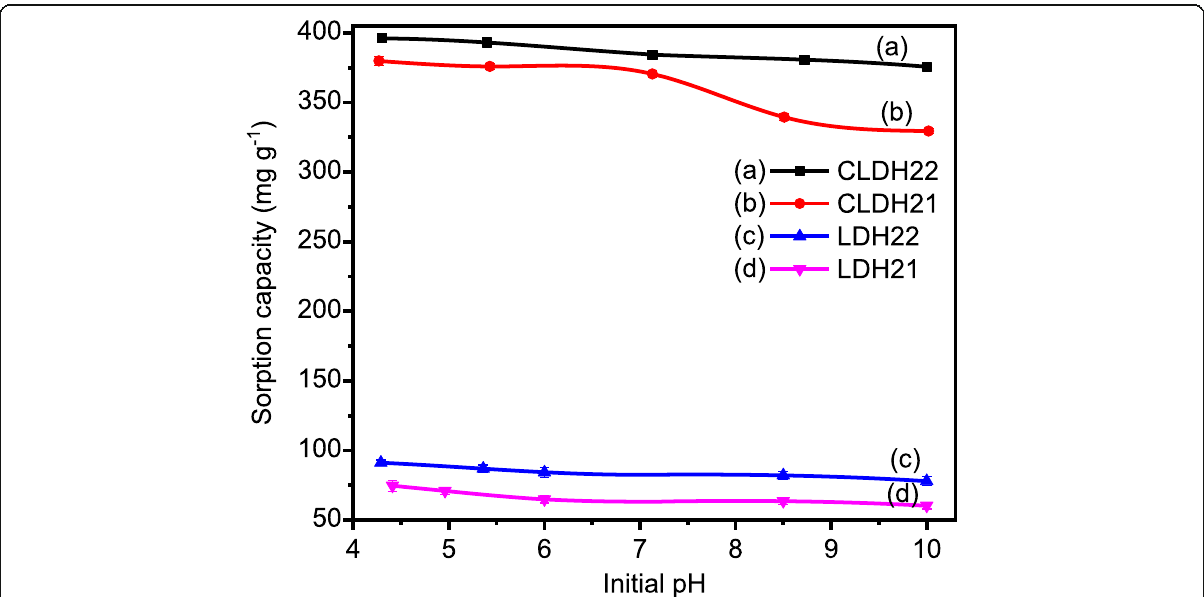
Fig. 4 Effect of initial pHs on adsorption capacity of IDB dye onto LDHs and CLDHs adsorbent, (C i = 200 and 400 mg L − 1 for LDHs and CLDHs, M = 25 mg, V = 25 mL, temperature = 30 ± 2